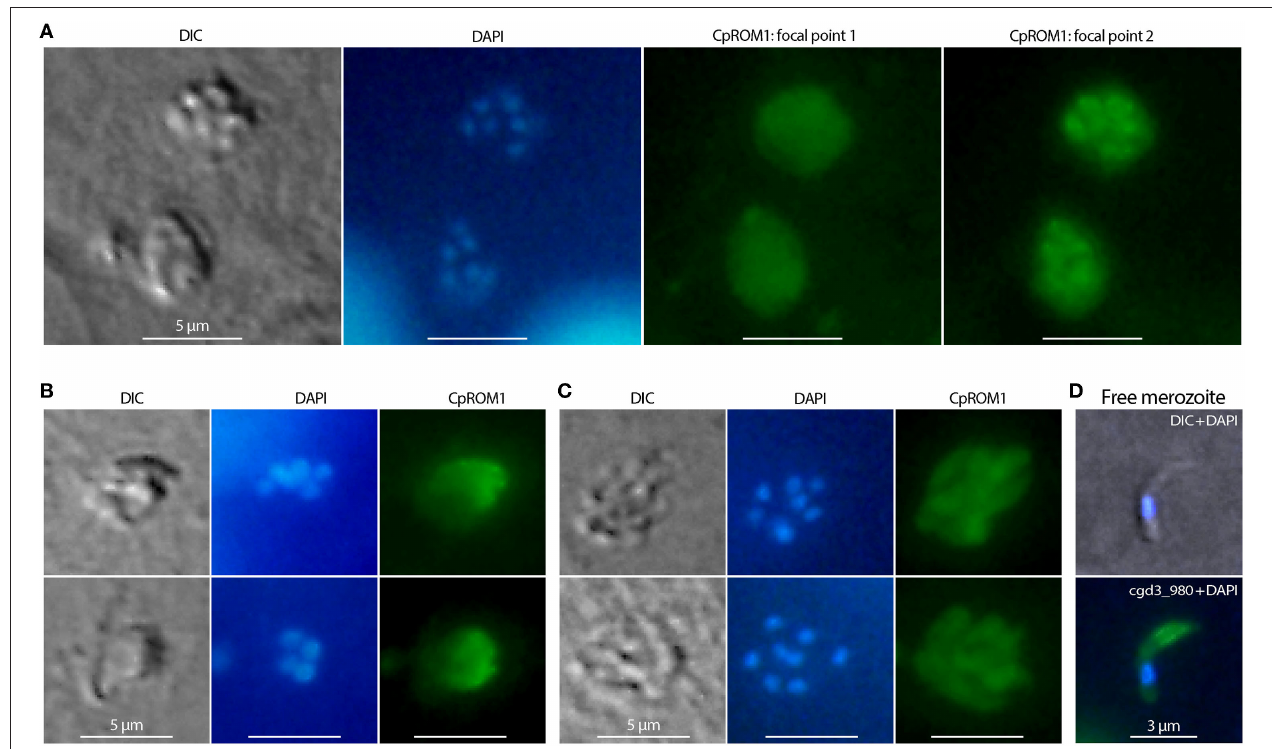
FIGURE 6 | Immunofluorescence assay (IFA) detection of CpROM1 in intracellular Cryptosporidium parvum . Intracellular type I or II meronts containing up to eight nuclei counterstained with 4,6-diamidino-2-phenylindole (DAPI) (blue) and labeled with anti-CpROM1 antibody (green). Cell morphology was illustrated using differential interference contrast (DIC) microscopy. (A) IFA of CpROM1 in two type I meronts at two different focal points showing relatively homogenous distribution of fluorescent signals on parasitophorous vacuole membrane (PVM) (focal point 1) and major signal distribution in the intracellular parasites (focal point 2). (B) IFA of CpROM1 in type I and type II meronts at a focal point showing relatively homogenous signal distribution on a portion of PVM. (C) IFA of CpROM1 in two type I meronts showing signals in intracellular merozoites. (D) IFA of CpROM1 in a free